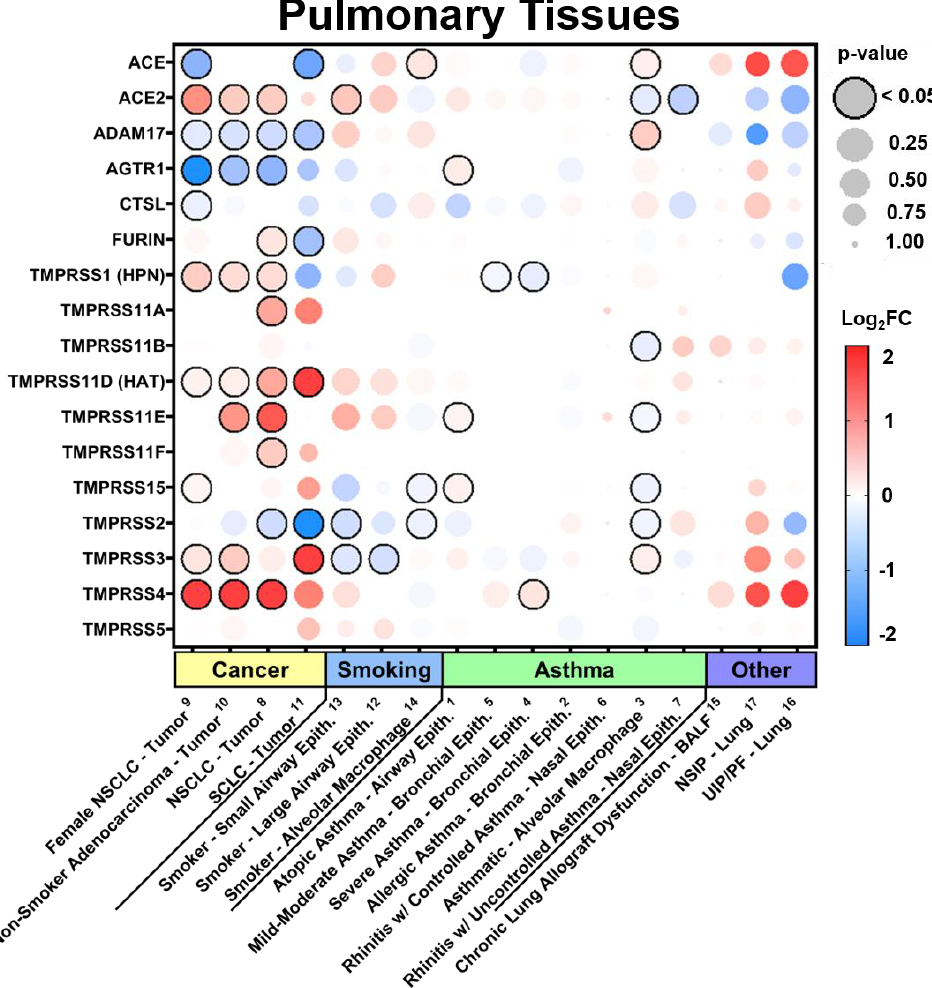
Figure2. SARS-CoV-2viral-entrygeneexpressioninpulmonarytissuesacrosscomorbidities. Expressionof Figure 2. SARS-CoV-2 viral-entry gene expression in pulmonary tissues across comorbidities. select SARS-CoV-2 viral-entry genes in pulmonary tissues across 17 DataSets representing various common Expression of select SARS-CoV-2 viral-entry genes in pulmonary tissues across 17 DataSets comorbidities. Values are displayed as logarithm to base 2 of the fold change (log 2 FC) in comparison with respective unaffected control samples from each DataSet. Comorbidity groups and each DataSet within are sortedfromgreatest( left )toleast( right )expressionof ACE2 . Heatmapcolorationissettoascaleof − 2(blue) to 2 (red) and values beyond this range are shown as either − 2 or 2, respectively. Statistical significance is represented proportional to dot size where largest dot size indicates highest statistical significance as indicated in the key and a black border designates p < 0.05. Superscript numbers link each DataSet to additional information found in Appendix A and Supplementary File 1. BALF = Bronchoalveolar lavage fluid; NSCLC = non-small cell lung carcinoma; NSIP = non-specific interstitial pneumonia; SCLC = small cell lung carcinoma; UIP / PF = usual interstitial pneumonia / idiopathic pulmonary